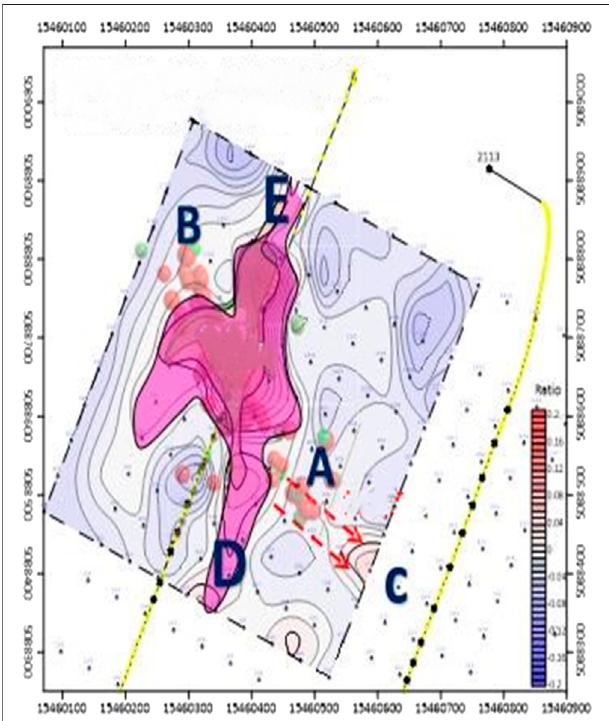
FIGURE 12 | Comprehensive analysis of the second-stage temporary plugging of the M7 well.